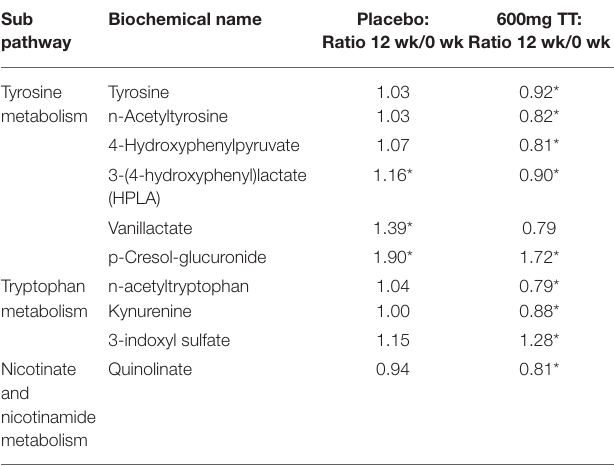
TABLE 3 | Changes in metabolites associated with tyrosine and tryptophan metabolism in serum of the Placebo and the 600mg TT groups at 0 and 12 wk. Sub